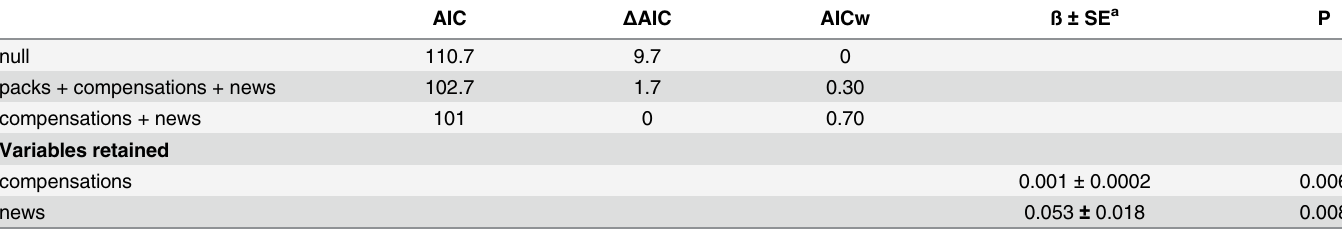
Table 4. Models fitted to the number of wolves culled per